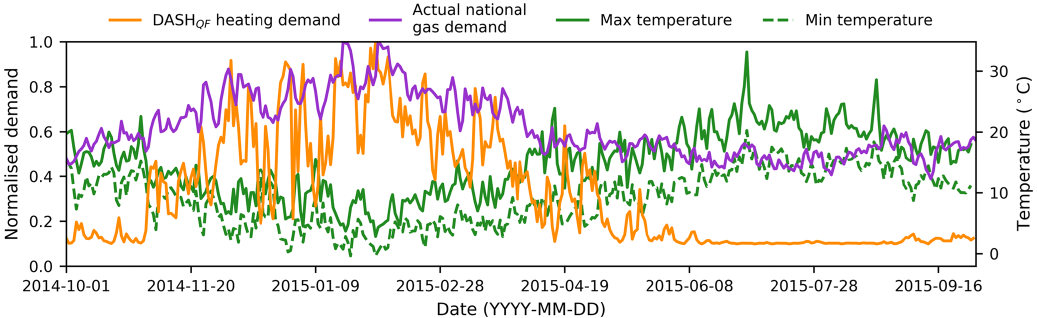
Figure 10. Daily (1 October 2014–30 September 2015) DASH normalised total HC and DHW energy demand (R7, Table 6) for Greater London, minimum and maximum London outdoor air temperature ( ◦ C) (Table 5), and normalised national gas demand (NG, 2015). See Sect. 3.2 for